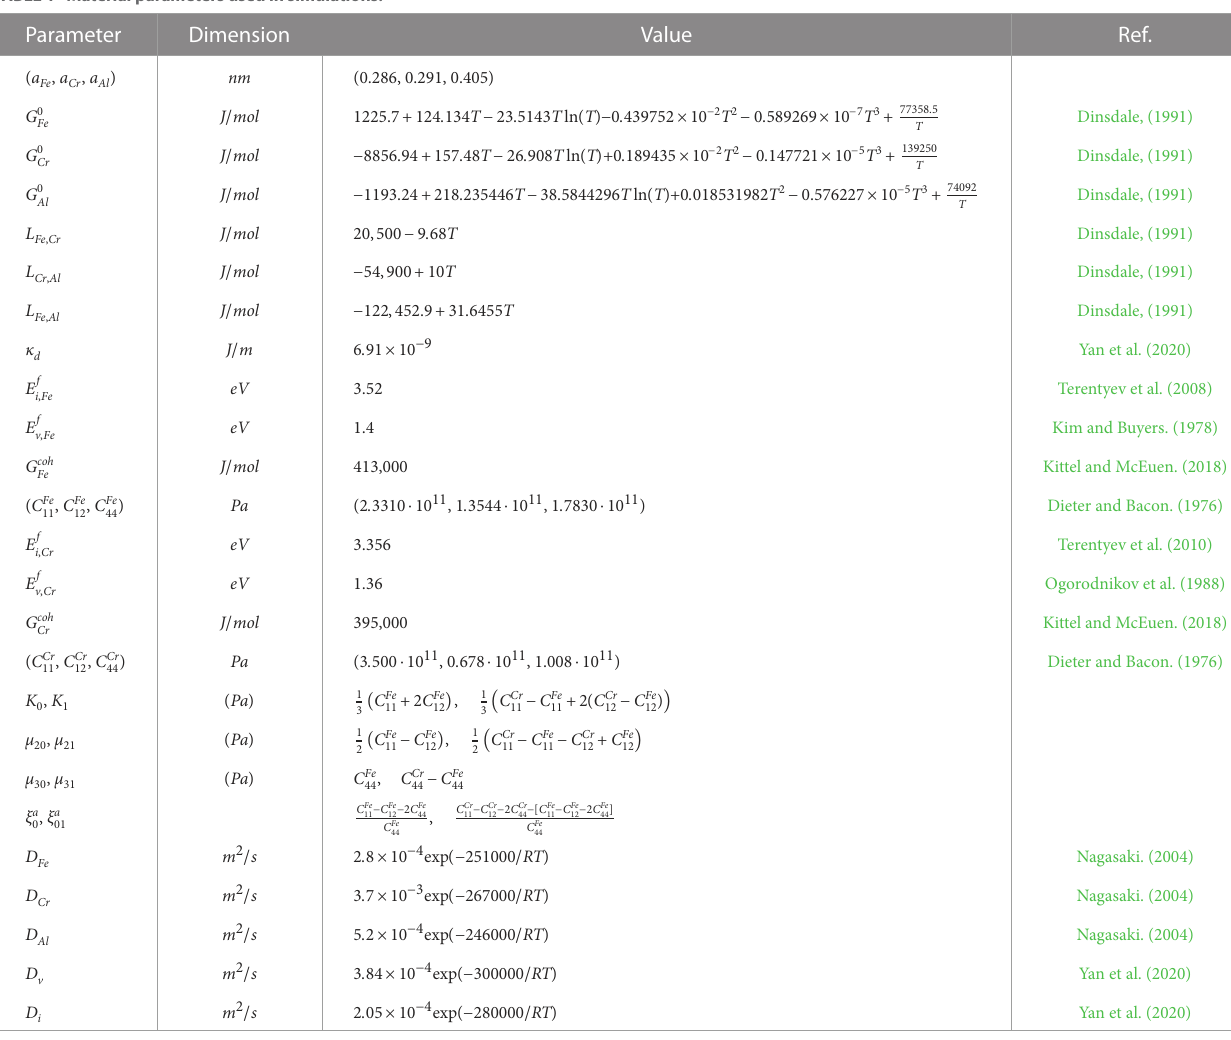
TABLE1 Materialparametersusedinsimulations. Parameter Dimension Value